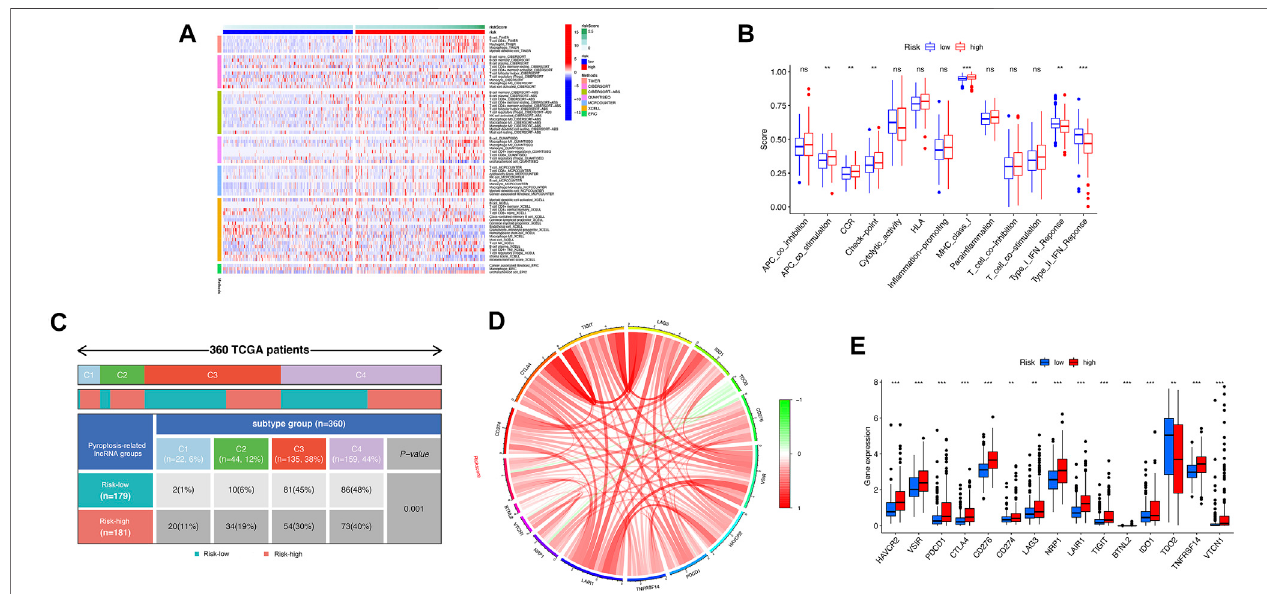
FIGURE7| Correlation analysiswasperformed betweentheriskmodelandimmunestatus. (A) Theassociationbetweenimmunecellin fi ltration andtheriskscore using the different algorithms. (B) The boxplot illustrating the difference in immune-related functions between the high- and low-risk groups. (C) Comparison in the differences in immune subtype between different risk groups. (D) Chord diagram illustrating the correlations between the expression of 15 key immune checkpoint genes, as well as between the mRNA expression of 15 key immune checkpoint and the risk score. (E) The boxplot displaying the difference in immune checkpoint genes between the high- and low-risk groups. ns, not signi fi cant; * p < 0.05; ** p < 0.01; *** p <